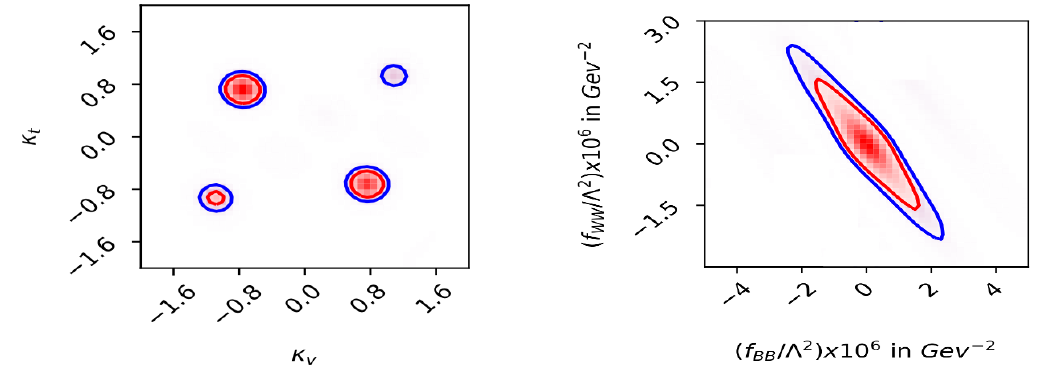
Figure 11 . Allowed regions at 1 (cid:27) (red) and 2 (cid:27) (blue) levels in the parameter space of scale factors and dimension-6 couplings in Lepton-speci(cid:12)c